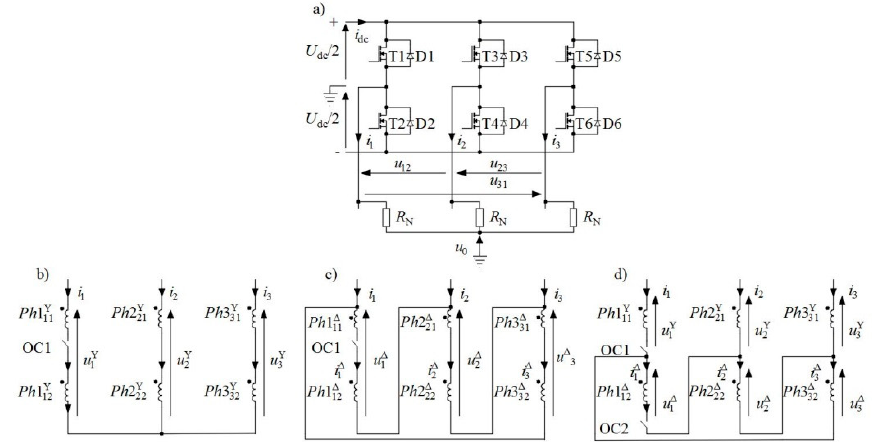
Figure 1. Diagram of ( a ) supply to brushless direct current (BLDC) motor, and configuration of windings in ( b ) star (Y), ( c ) delta ( Δ ), ( d ) combined star–delta (Y Δ ) configurations.